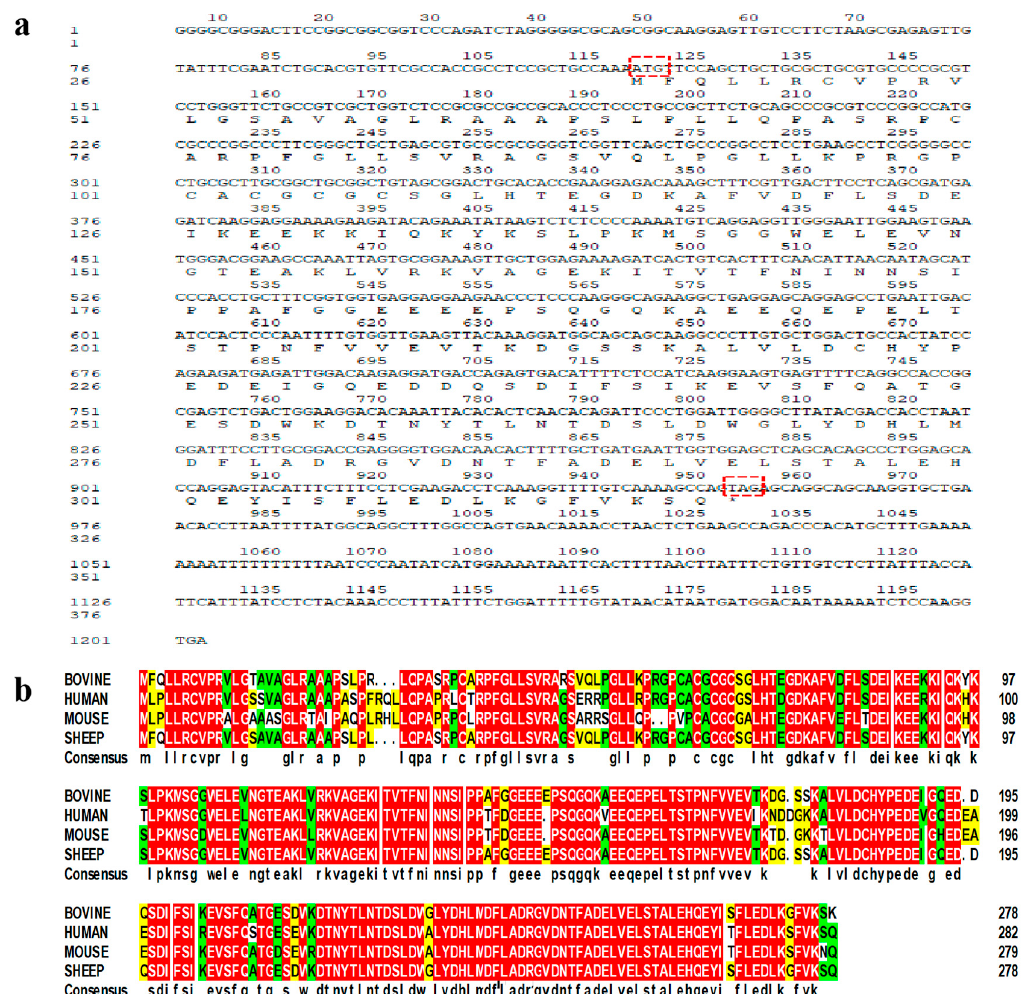
Figure 2. The cDNA fragment and predicted protein sequences of ovine p32 -CDS are also shown. The start and stop codons are framed in red ( a ). The protein sequence was predicted by the BLAST tool of DNAMAN (version 6.0, LynnonBiosoft, San Ramon, CA, USA) and is presented under the coding sequence. * means the translation is terminated. ( a ) Comparison of the bovine, mouse, and human